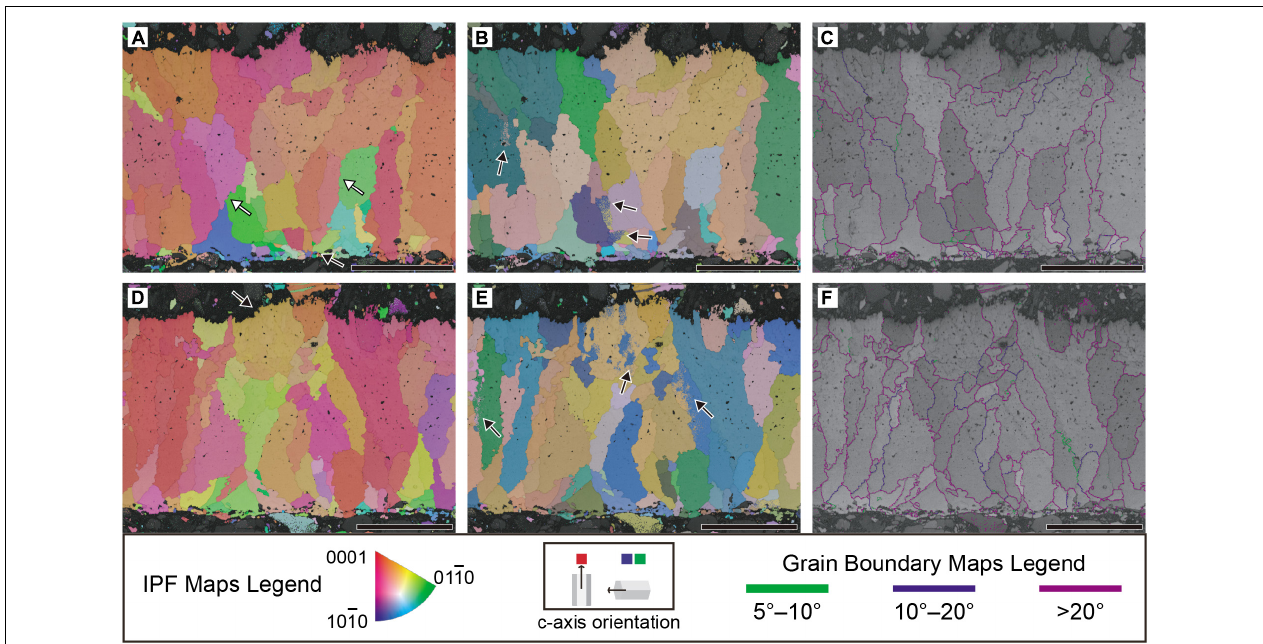
FIGURE 7 | Crystallography of Aenigmaoolithus vesicularis oogen. et oosp. nov. (SNUVP 201704). (A,D ) Inverse pole figure (IPF) maps; (B,E) , Euler maps; (C,F) , grain boundary maps. In IPF maps, when c -axis of a calcite grain lies perpendicular to the eggshell surface, it is colored red. When lies parallel to the eggshell surface, it is colored green or blue. In Euler map, different grains have a different color so that it is easy to differentiate calcite grains. In grain boundary maps, boundary angle 5 ◦ –10 ◦ is colored green, 10–20 ◦ dark purple, and > 20 ◦ light purple. In (A) , note wedge-like shell units marked by white arrows. The radiating calcite grains in the inner end are very similar to a mammillary layer of archosaur eggs (a black arrow in A ). An ornamentation is marked by a black arrow in (D) . Note the crystallographic continuity between the ornamentation and underlying eggshell. In (B,E) , the color gradation marked by black arrows is limitation of visual representation of Euler map, not a biological phenomenon, thus crystallographically insignificant. (C,F) Most grain boundaries are higher than 20 ◦ . All scale bars equal 100 µ m.